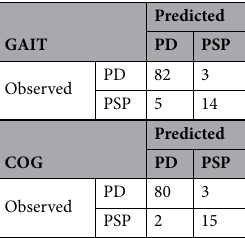
Table 4. Confusion matrix of binary logistic regression (PD Vs PSP) for GAIT and COG tasks. PD Parkinson’s disease, PSP progressive supranuclear palsy.